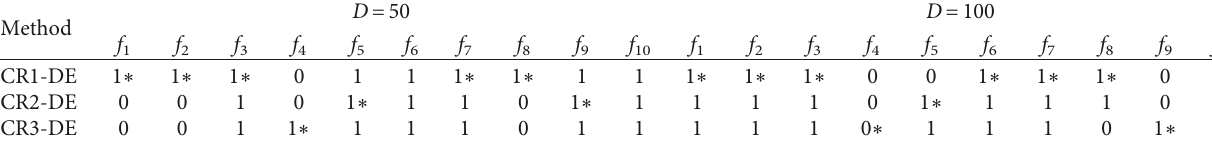
Table 4: States of three changing strategies according to their testing